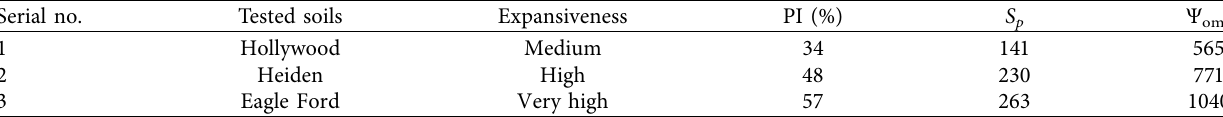
Table 5: Specification of the independent expansive soils utilized for validation.